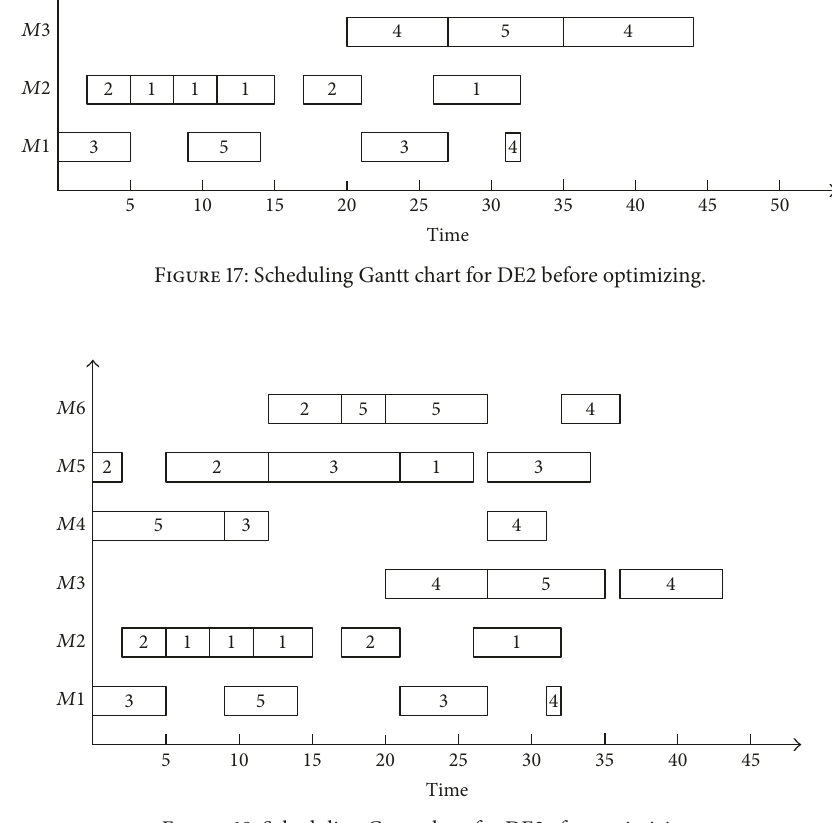
Figure 18: Scheduling Gantt chart for DE2 after optimizing.